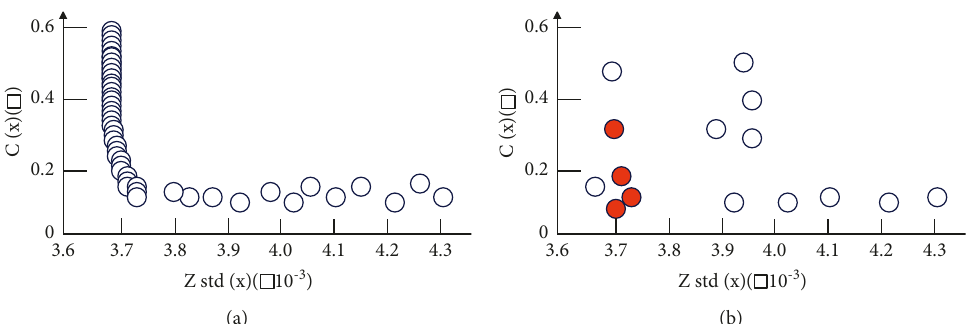
Figure 8: The optimal solution set optimized by the improved genetic algorithm: (a) front edge optimization; (b) front edge after integer.